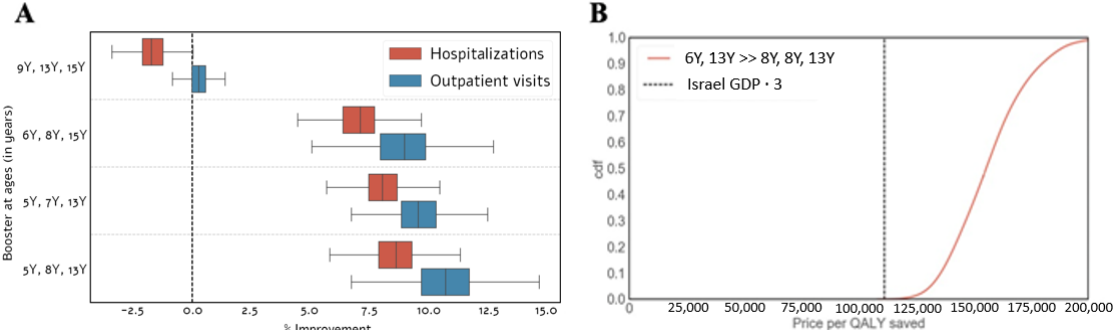
Figure 5. Cost-effectiveness of adding a third booster dose. ( A ) Effectiveness of different vaccination schedules with three booster doses in terms of reducing pertussis outpatient visits and hospitalizations as projected by our model. Effectiveness is reported as the percentage of improvement compared to the optimal two-booster schedule, which targets children at the ages of 6 and 13. ( B ) Cost-effectiveness of the optimal three-booster schedule compared to the optimal two-booster schedule.